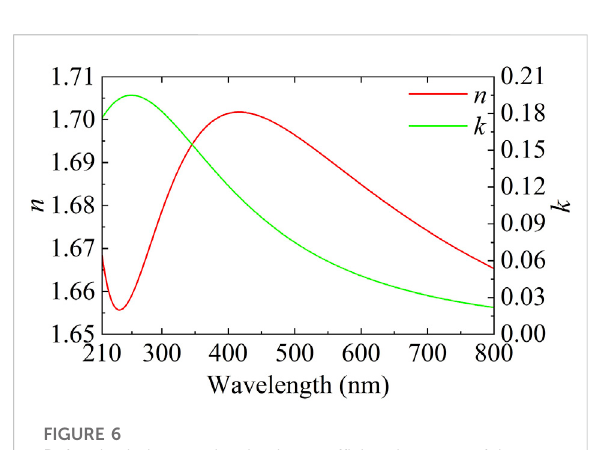
FIGURE 6 Refractive index n and extinction coef fi cient k spectra of the DLC fi